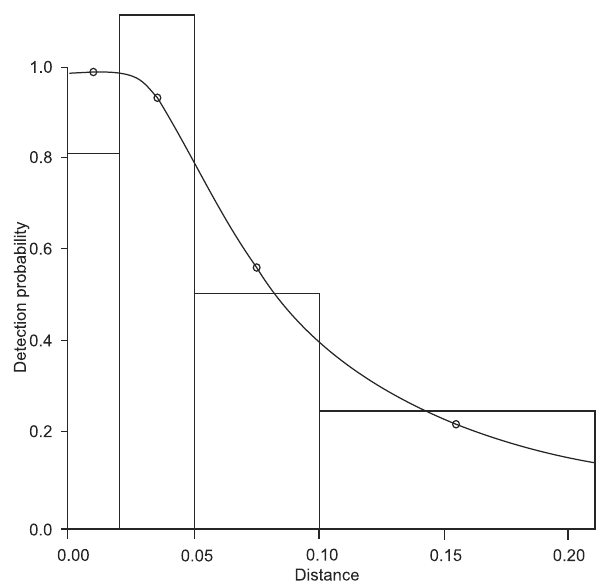
Figure 4. Frequency distribution of the sightings of marsh deer. The continuous curve represents the best fit function (hazard rate). The pooled distances are presented in